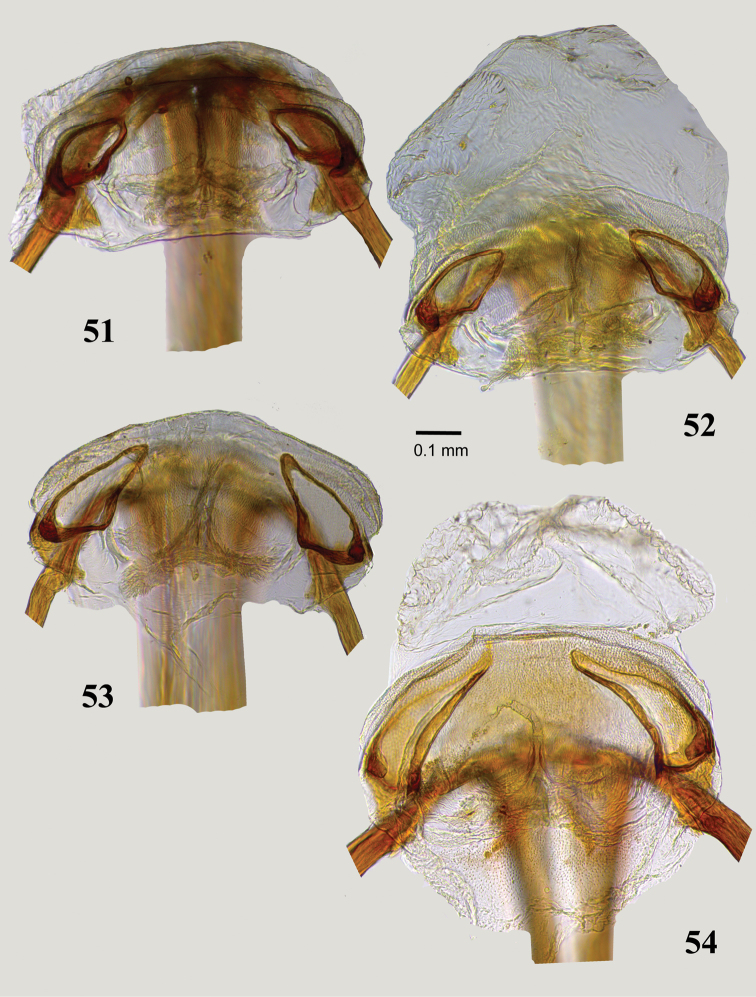
Dorsal labiate plate of bursa copulatrix: 51Myrmecophyesarmeniacus Drapolyuk, 1989, 52Myrmecophyestomi sp. n. 53Myrmecophyesheterocerus Horváth, 1927 54Myrmecophyesnasutus Drapolyuk, 1989.